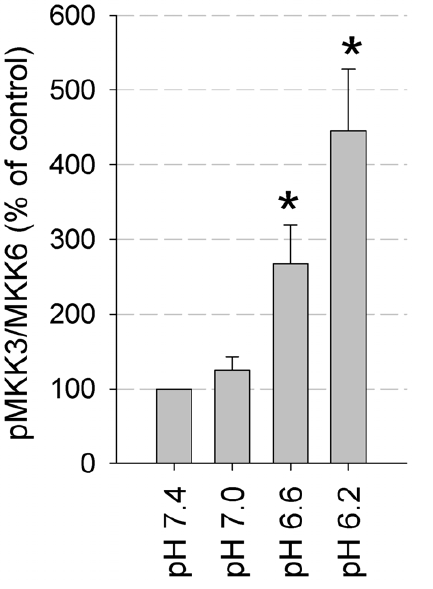
Figure 5. Acidosis-induced phosphorylation of MKK3/6. Values represent the ratio of phosphorylated protein (pp38 or pERK) divided by total protein (p38, ERK). These values have then been normalized to the ratio of control experiments at pH 7.4. (*) p , 0.05 versus pH 7.4. (N=4).